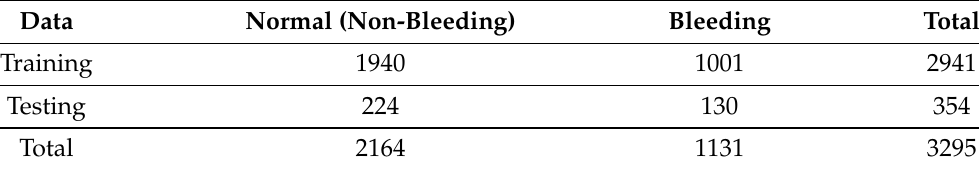
Figure 8. Model’s accuracy and loss. Table 2. Normal (non-bleeding) and bleeding images used for training and